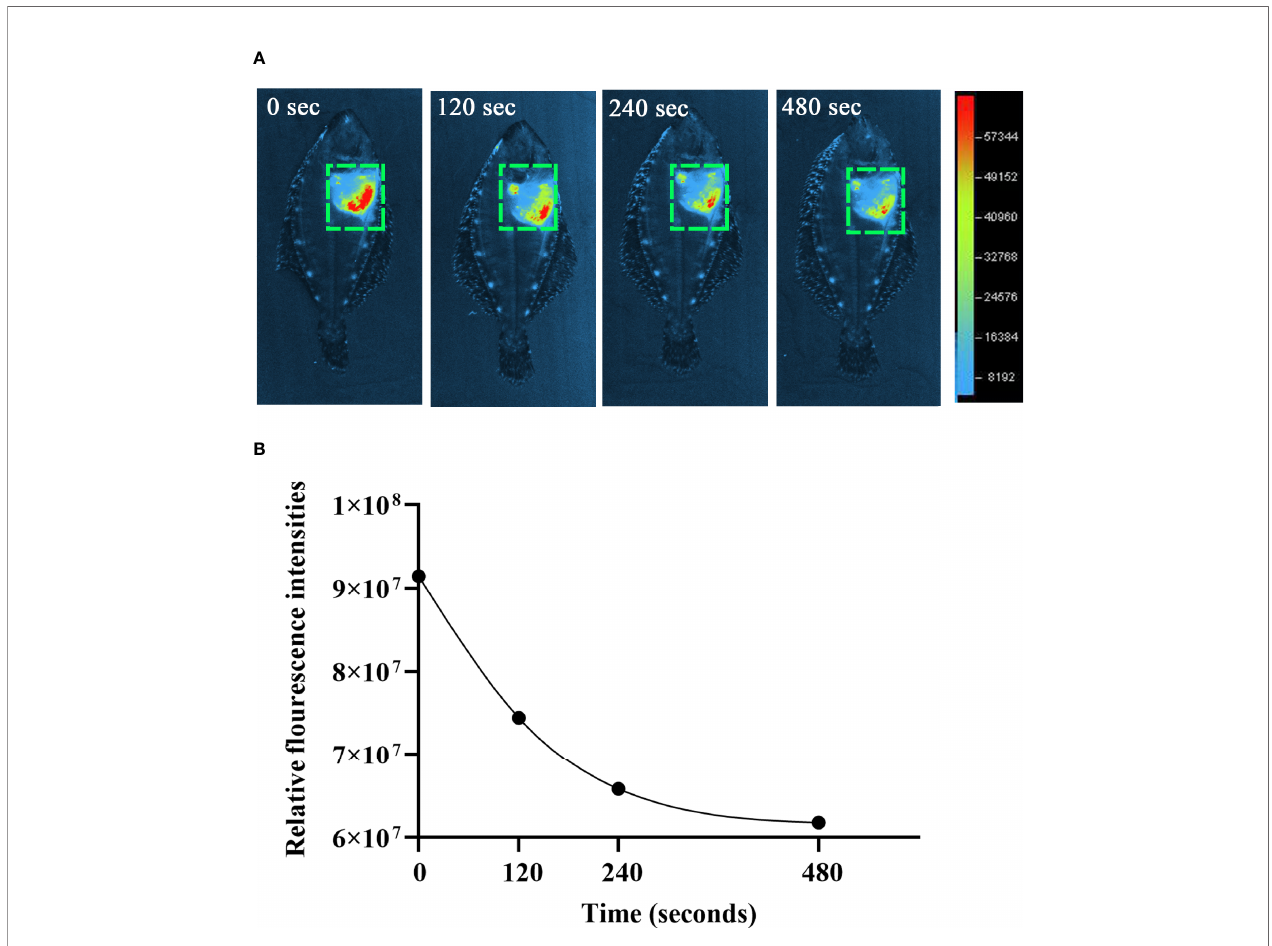
FIGURE 5 | The degradation of extracellular DNA structures at intraperitoneum after exogenous DNaseI injection. (A) After ovalbumin (OVA)/Alum-immunized for 12 h, fl ounder was injected with Sytox Green and DNaseI. The images were taken by small animal in vivo imaging instruments at different times. (B) Quantitative analysis of fl uorescence in fl ounder peritoneum at different times after DNaseI injection. These representative data are from the study of 10 independent fi